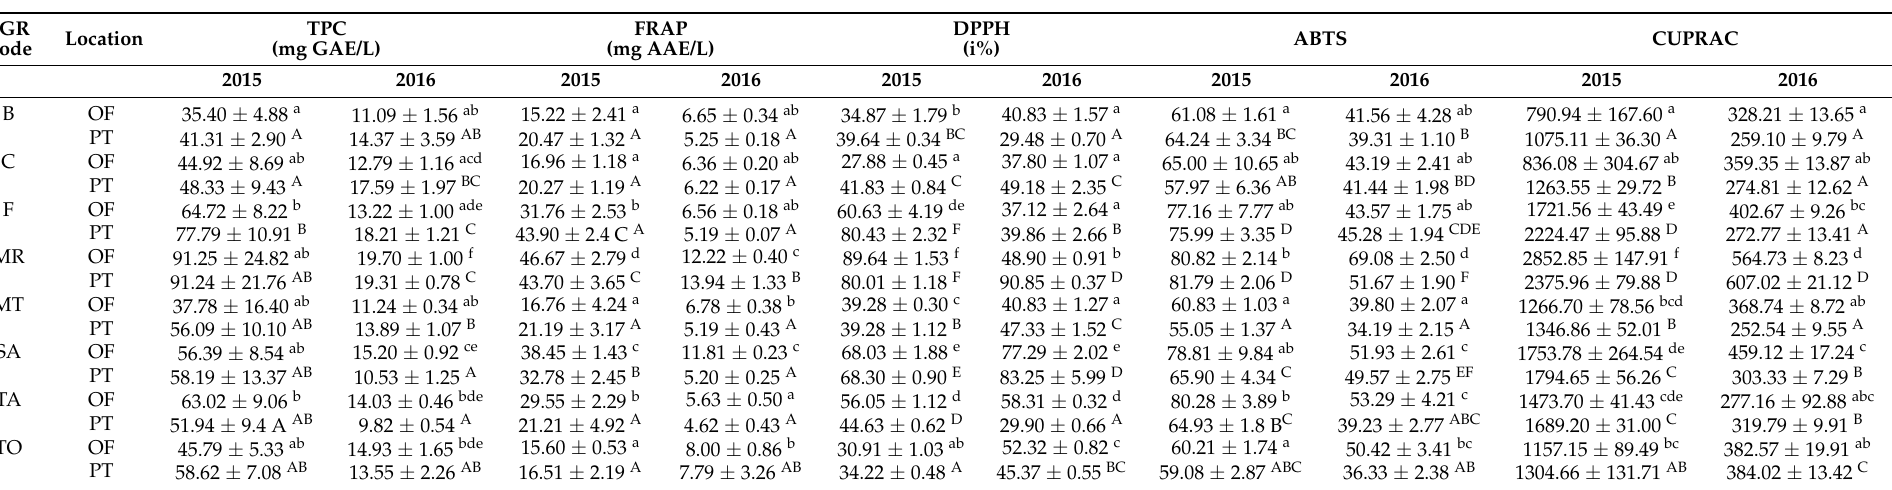
Table 4. Antioxidant capacity (mean ± sd) of the seven Hungarian tomato PGRs investigated and the control variety, measured by five different assays, in the open field and in the polytunnel, in 2015 and